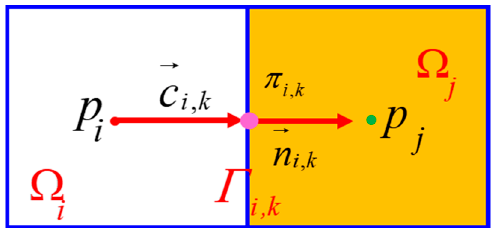
The half-conductivity T i , j is related to a single cell, and provides a two-point relation between the flux across a cell face and the pressure difference between the cell and face centroids, as shown in Figure 1.